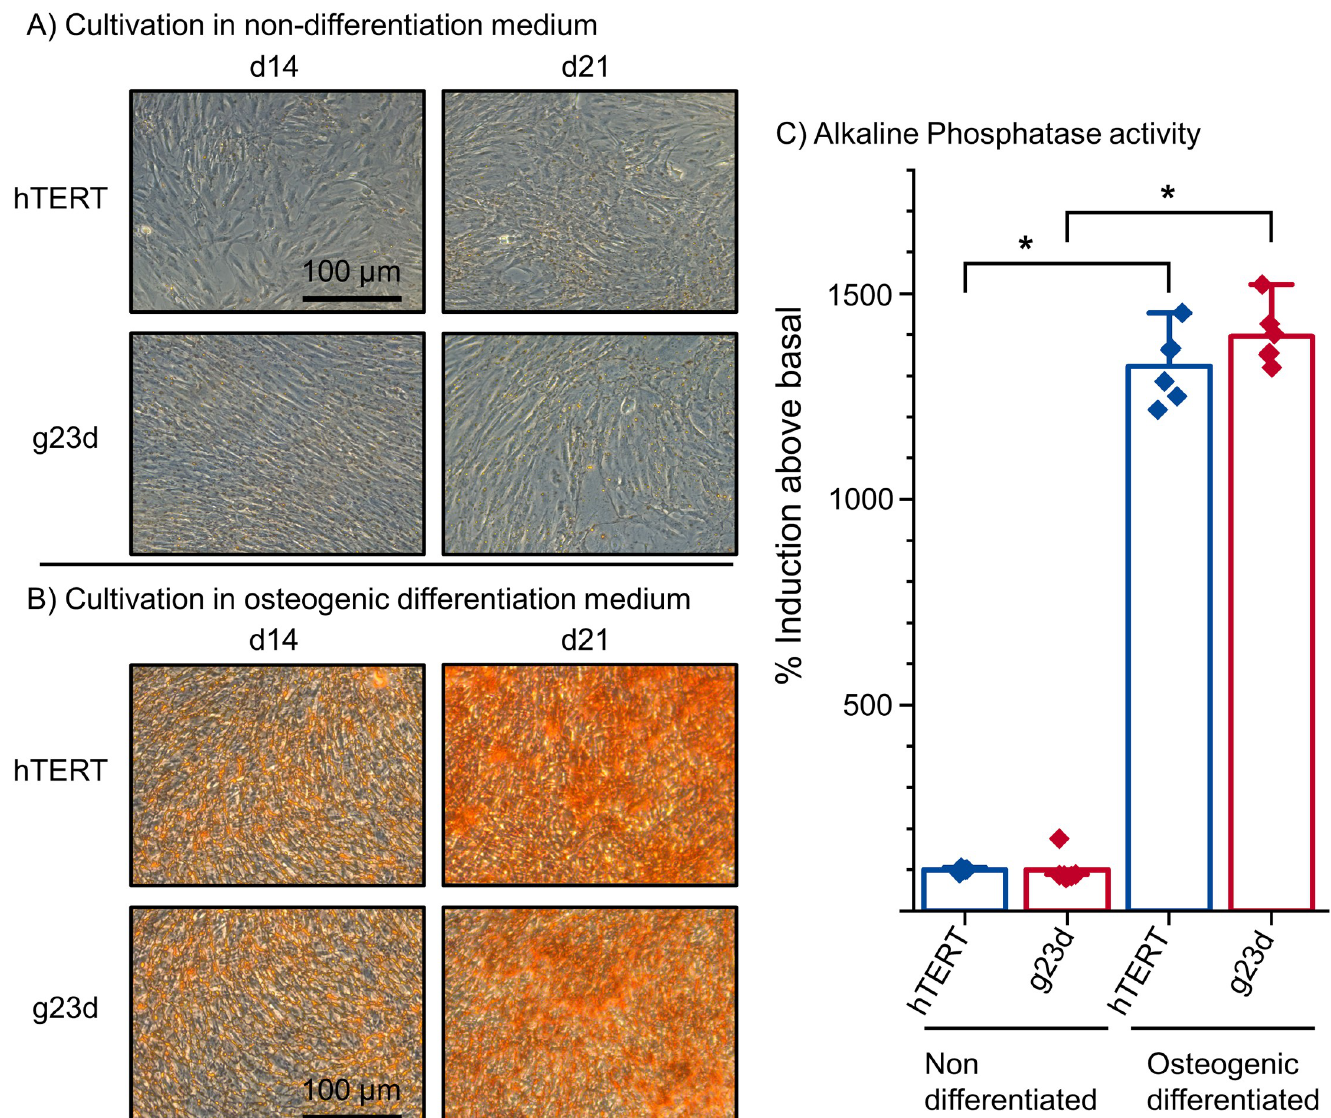
Fig 6. Osteogenic differentiation of hTERT MSCs. Clone g23d along with hTERT MSCs control cells were cultivated in (A) MEM alpha Medium (non- differentiating) and in (B) osteogenic differentiation medium (ODM) in order to induce osteoblast differentiation. Cells in ODM showed osteogenic differentiation, the red staining of cells indicated calcified deposits. Both, hTERT MSCs and clone g23d, readily differentiated into osteoblasts. (C) Alkaline phosphatase activity of differentiated—g23d- and non-differentiated hTERT control MSCs were assayed with the CSPD-ALP method. Statistical significance between non- and osteogenic differentiated cells is indicated: t-test (n = 6) � p <